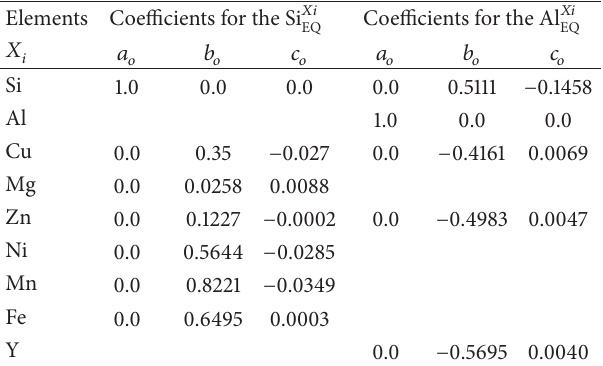
Table 1: Polynomial coefficients for the Si 𝑋 𝑖 and